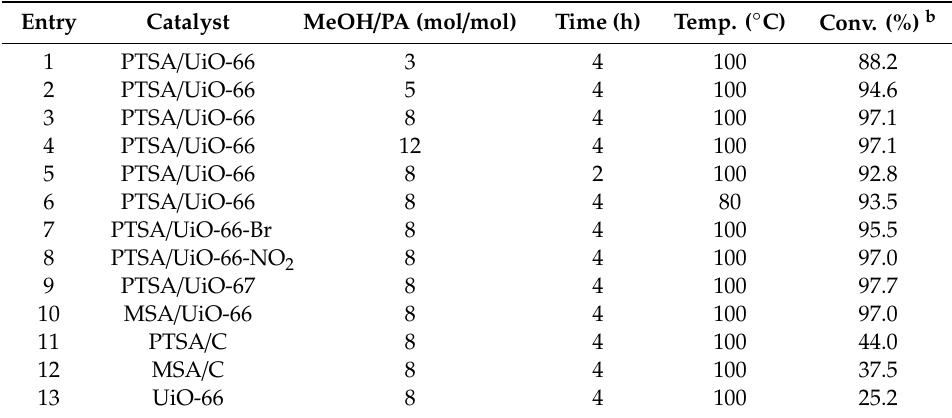
Table 2. Esterification of palmitic acid (PA) with methanol a